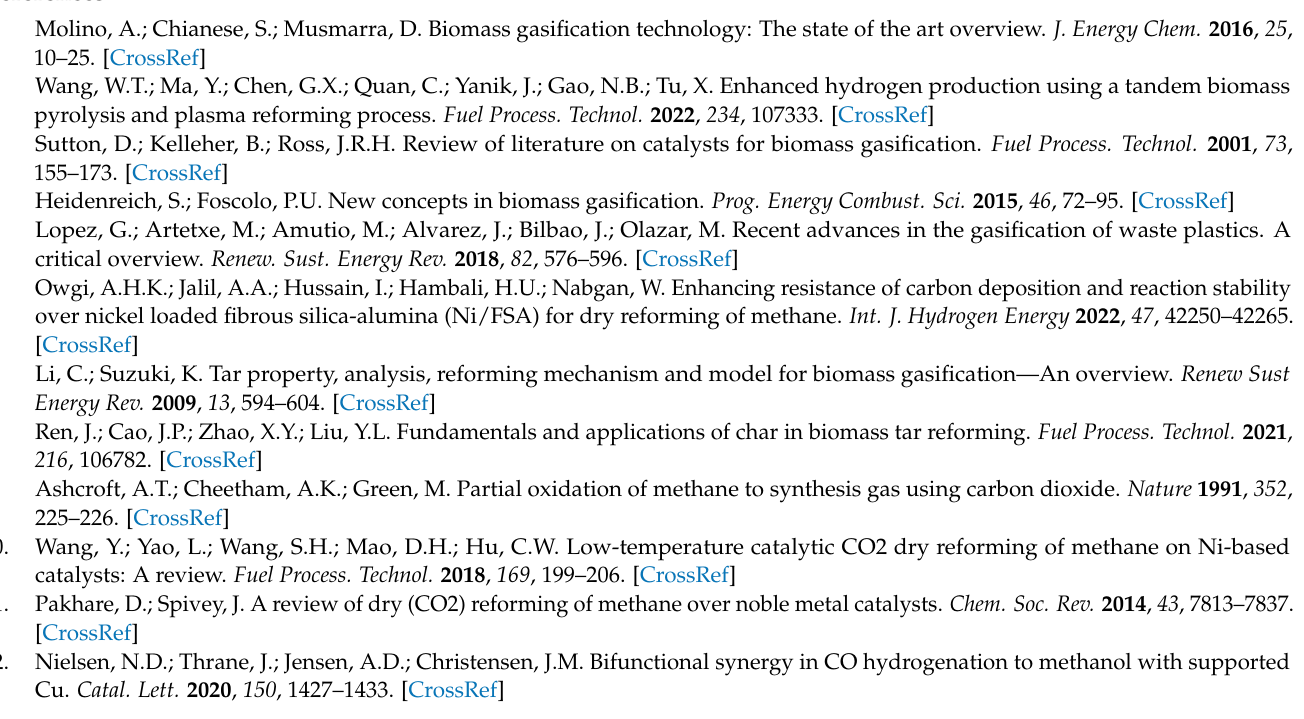
catalysts; Figure S5. GC–MS spectrogram of benzene removal under a gas mixture (N 2 , CH 4 and CO 2 ) atmosphere and a pure N 2 atmosphere; Figure S6. Schematic diagram of the experimental setup; Table S1. Relative contents of the peaks of the spent catalysts; Table S2. H 2 molar flow from plasma − coupled catalytic processes; Table S3. Catalyst characterization data; Table S4. Main products identified in the liquid sample by